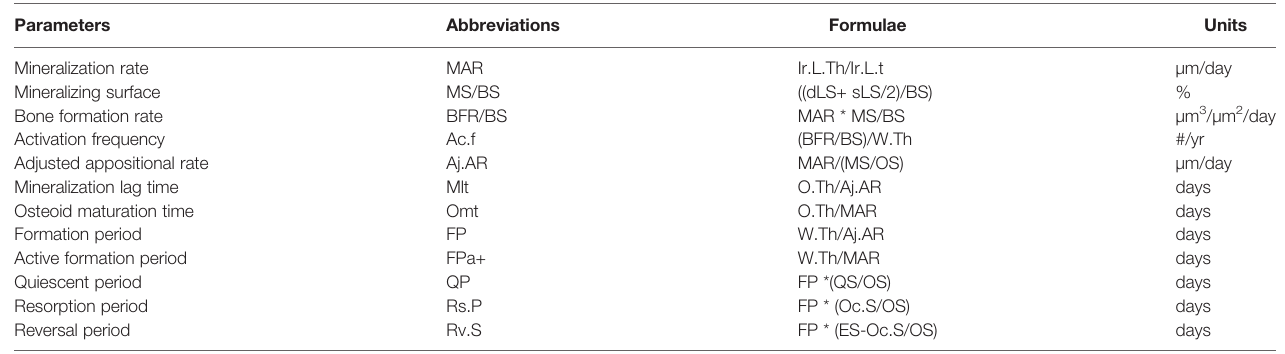
TABLE 2 | Derived histomorphometric parameters of bone remodeling and